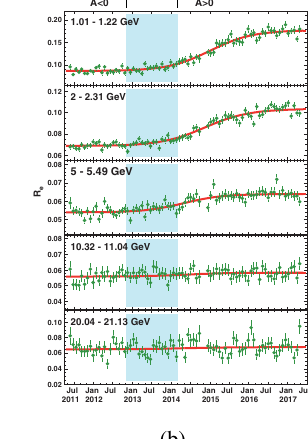
FIG.4. ResultsofthefitsoftheparametrizationinEq.(3)tothe ratio R e asafunctionofenergy(bluecircles):(a) Δ t andthebest- fit constant value of830days(red line),(b) t 1 = 2 − t rev with the parametrizationaccordingtoEq.(4)(redcurve),(c)amplitude C FIG.3. Theratio R e ofthepositronfluxtotheelectronfluxasa with a dashed line at zero to guide the eye. function of time. The error bars are statistical. The best-fit parametrization according to Eq. (3) is shown by red curves. The polarity of the heliospheric magnetic field is denoted by A< 0 and A> 0 . The period without well-defined polarity is marked by the shaded area [17]. (Fig. SM 6 [34]) are well reproduced by advanced numerical solar modulation models [22]. But for the followingyears covered by the new data presented in this